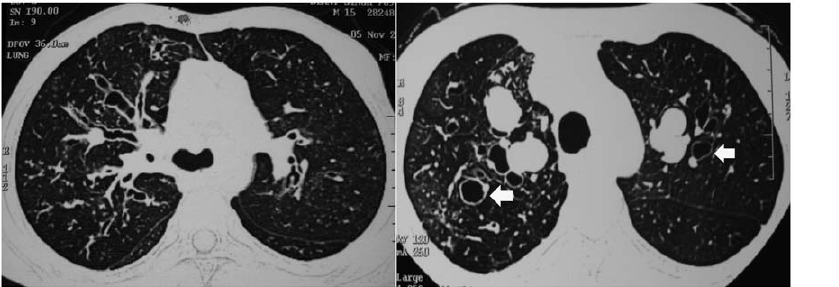
Figure 1. Presence of central bronchiectasis in two different patients with allergic bronchopulmonary aspergillosis. The presence of classic signet ring appearance of dilated bronchi is easily appreciable (arrows). The bronchiectasis is located predominantly in the inner half of the lung fields. doi:10.1371/journal.pone.0015346.g001 PLoS ONE |